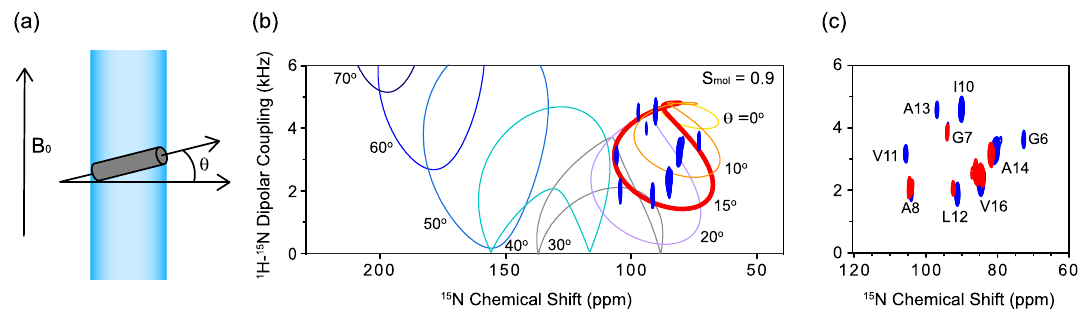
Figure 2. ( a ) Schematic of the magnetically aligned lipid bilayer (blue) and inserted Pf3_24_2 (gray). θ is the angle formed between the helix long axis of Pf3_24_2 and the membrane normal. ( b ) 1 H- 15 N SAMPI4 spectra of Pf3_24_2 (Fig. 1d) in the DMPC/DHPC bicelles ([DMPC]/[DHPC] = 3) aligned with their normal perpendicular to the magnetic field. The simulated PISA wheels with varied tilt angles θ (0–70°) are overlaid onto the spectra. The bicelle order parameter S mol is fixed at 0.9. ( c ) 1 H- 15 N SAMPI4 spectra of Pf3_24_2 in the absence (blue) and presence (red) of 2 mol% of